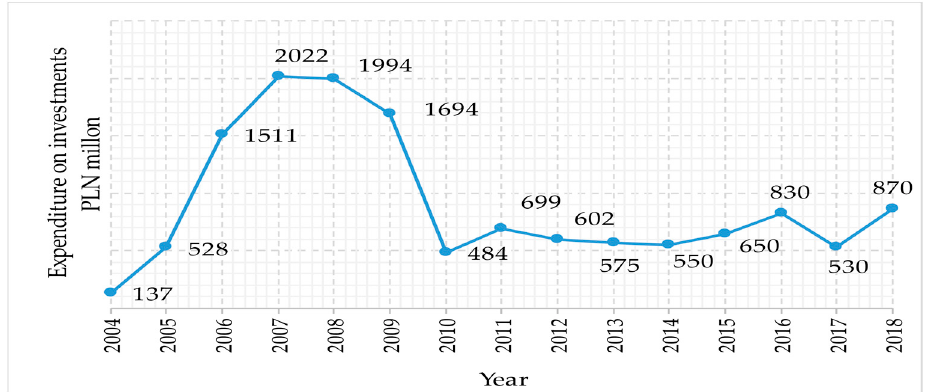
Figure 6. Expenditure on investments in the Polish steel sector from 2004 to 2018 * (* Inflation has not been taken into account as the cumulative method has been used to evaluate the value of investments. According to the Statistical Data, average inflation in Poland did not exceed 2.5%. in the analysed period).